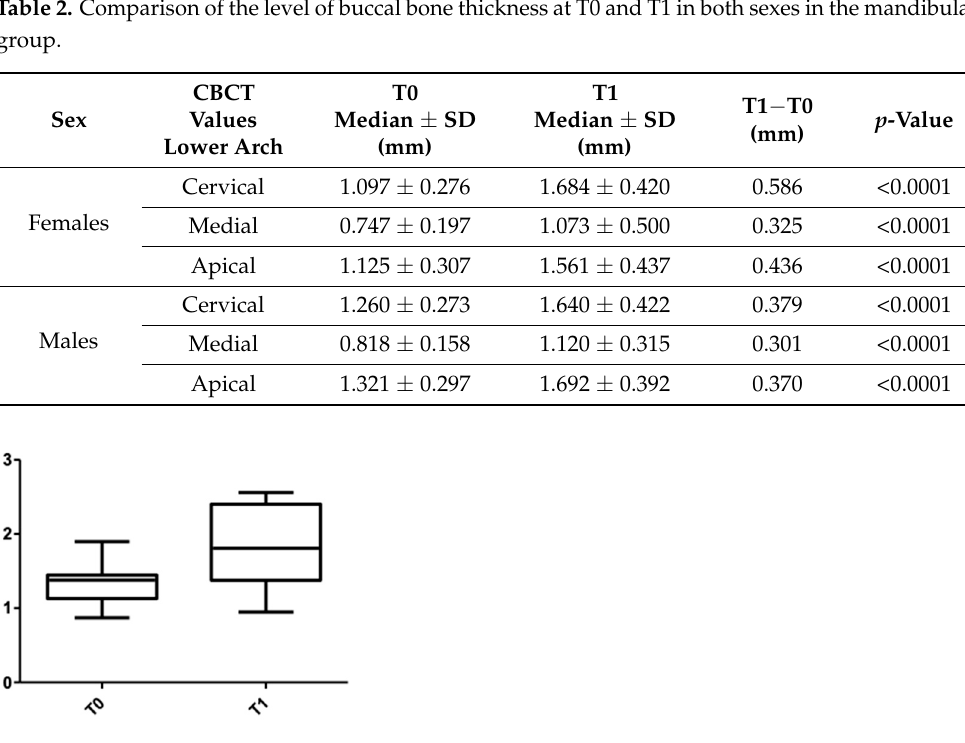
Table 2. Comparison of the level of buccal bone thickness at T0 and T1 in both sexes in the man- dibular group .